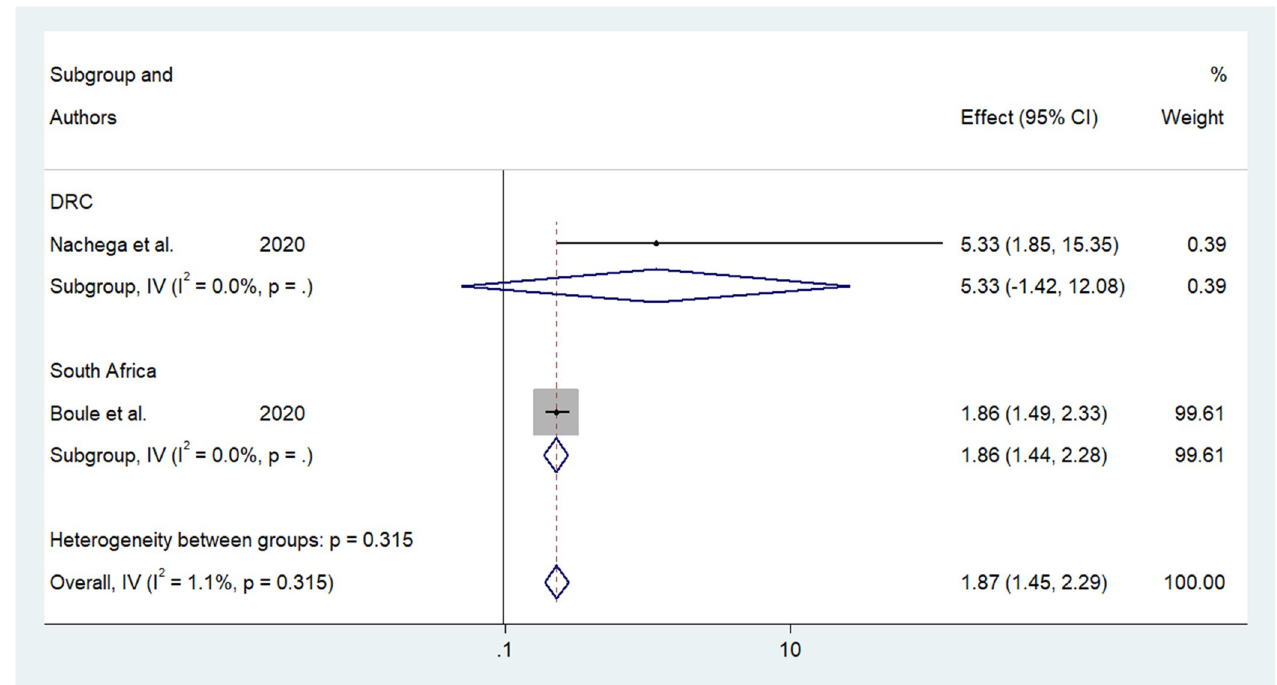
Fig 3. Forest plot showing the estimate for the effects of CKD on COVID-19 mortality.